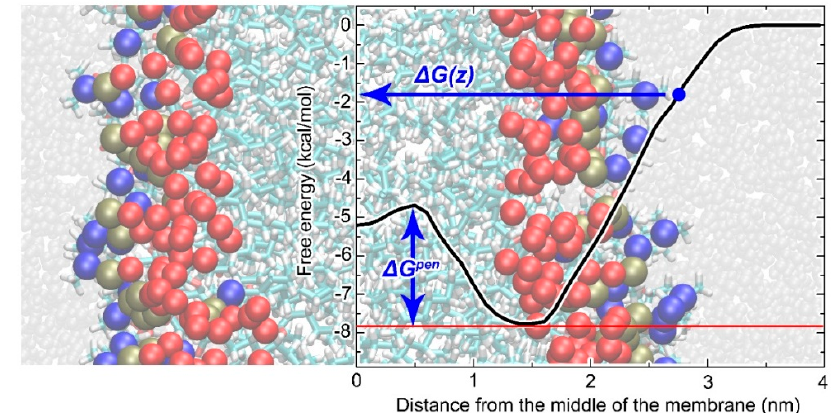
Figure 5. Structure of model membrane and free energy profile of penetration barrier. Lipid membrane constituents: the hydrocarbon chains in the membrane core are represented as cyan and white sticks; oxygen, phosphorus and nitrogen atoms in the DOPC membrane are shown as red, olive and blue balls; water molecules are represented as grey balls. The graph shows the free energy profile of the penetration barrier ( ∆ G pen ) and the free energy at depth z Δ G(z) .